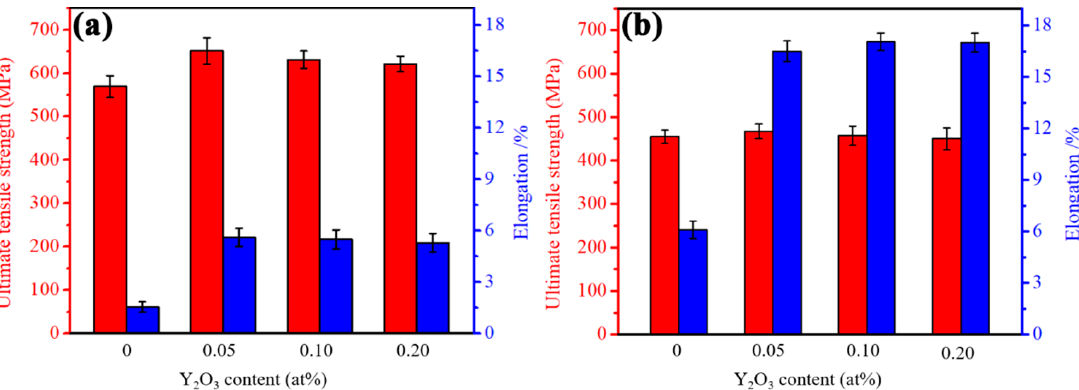
Figure 6. Ultimate tensile strength and elongation at elevated temperatures with different content of nano-Y 2 O 3 addition: ( a ) 800 °C; ( b ) 900 °C.